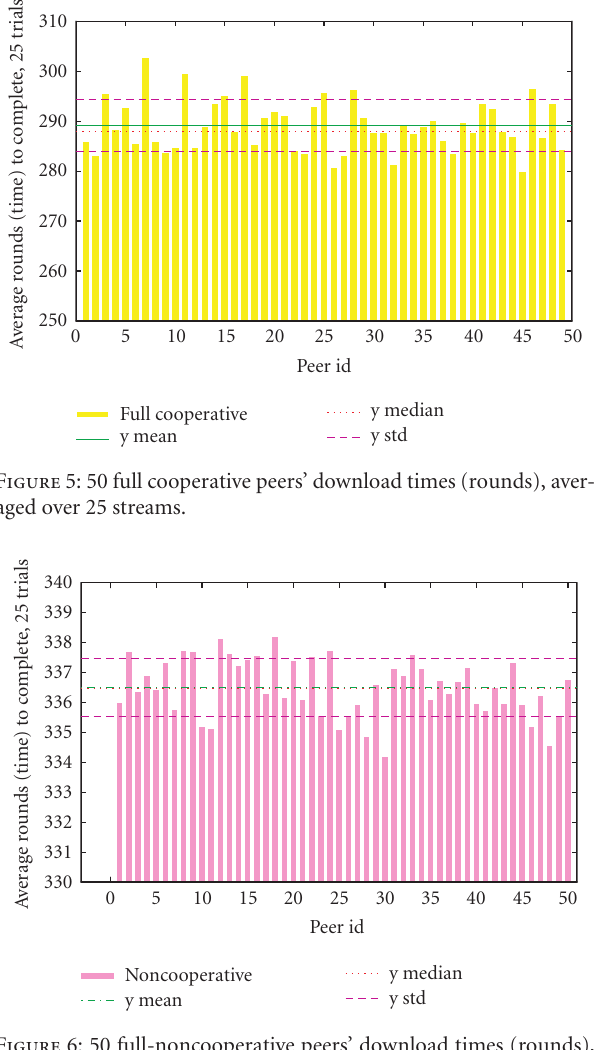
Figure 6: 50 full-noncooperative peers’ download times (rounds), averaged over 25 streams.